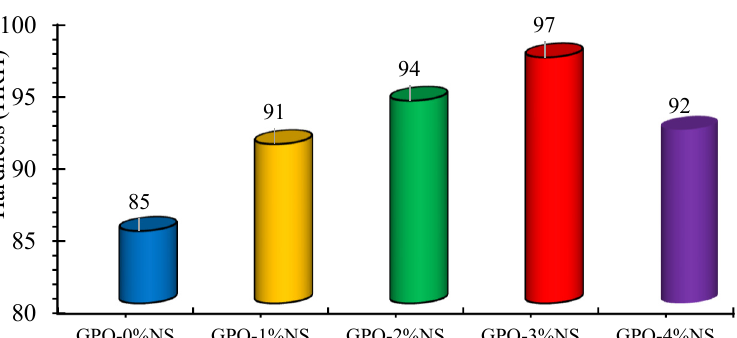
Figure 16. Variation in the HAD values of carbon-fiber-reinforced GPO composite pastes due to different proportions of NS.